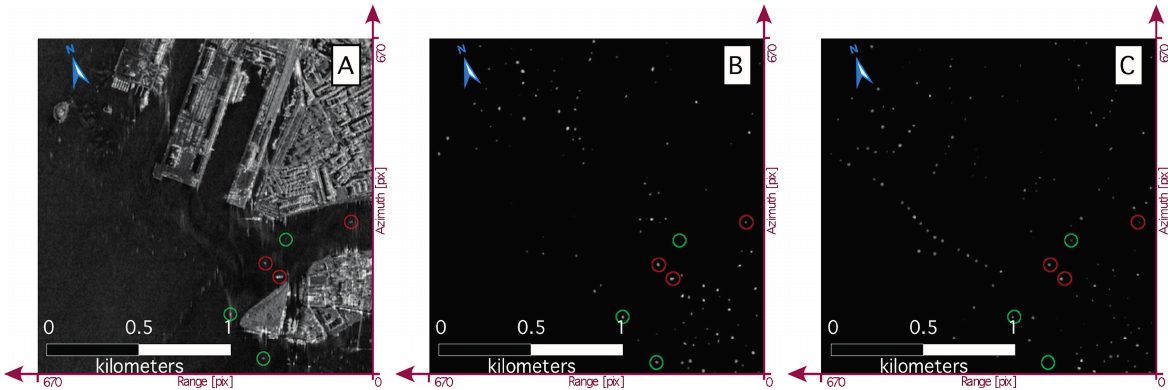
Figure 11. Location of vessels targeted for detection in ( A ) the April 16 acquisition and Constant False Alarm Rate processor (CFAR) detection comparison on ( B ) the intensity channel and on ( C ) the spectral coherence